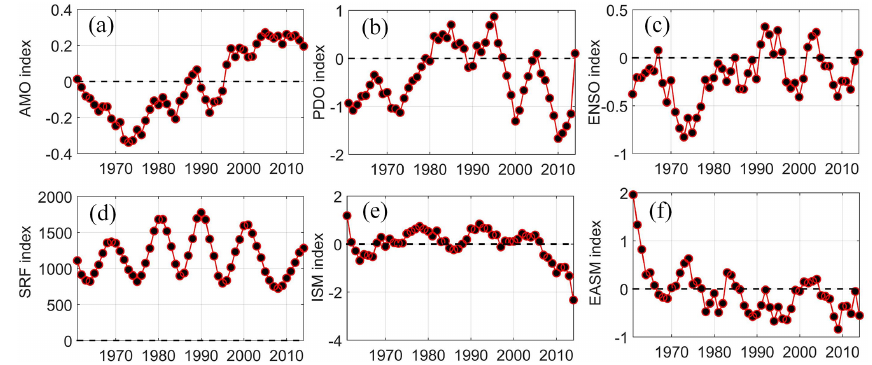
Figure 15. Inter decadal variations of the (a) AMO, (b) PDO, (c) ENSO (Niño 3.4), (d) SRF, (e) ISM, and (f) EASM index for June–July– August (JJA) over